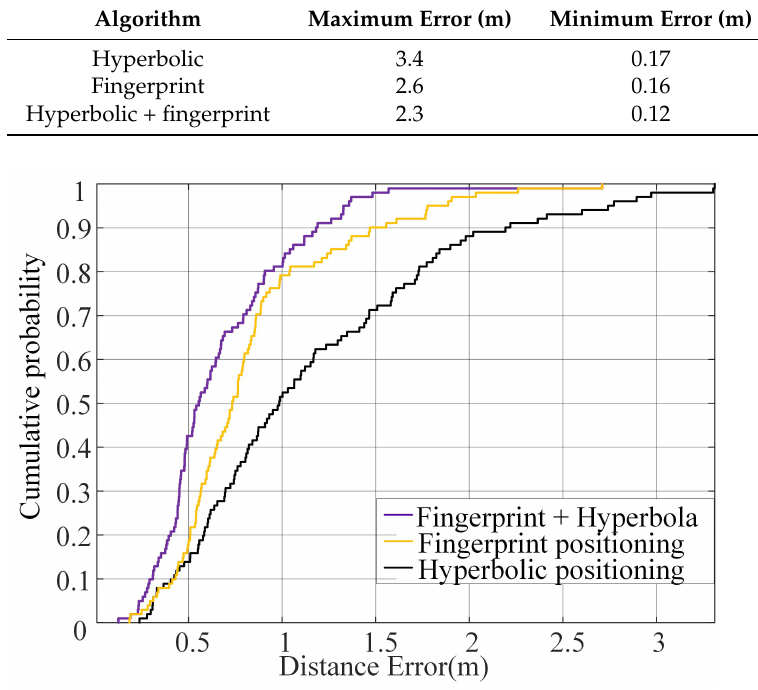
Figure 12. Comparison of the cumulative probability distribution of